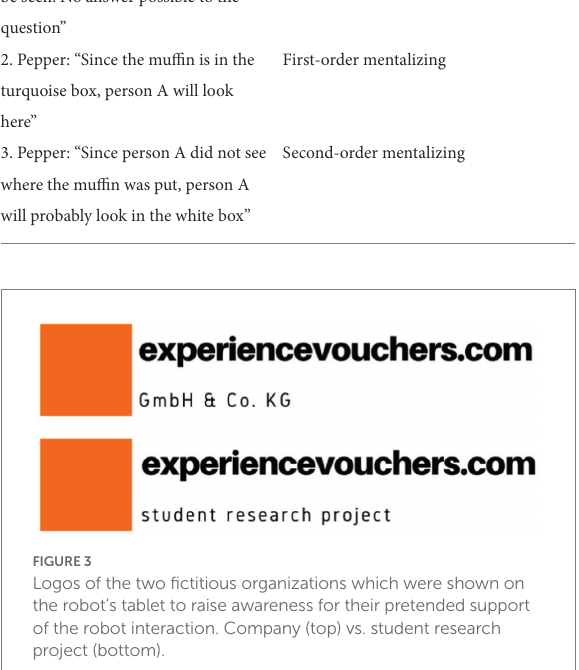
FIGURE 3 Logos of the two fictitious organizations which were shown on the robot’s tablet to raise awareness for their pretended support of the robot interaction. Company (top) vs. student research project